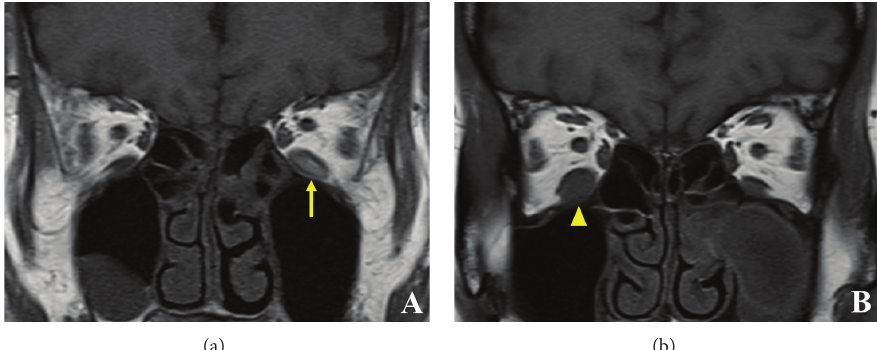
Figure 2: Adipose changes in the inferior rectus muscle (IRM) of a smoker (a) and nonsmoker (b). A large high-intensity area (arrow) in the left IRM is illustrated on a T1-weighted coronal magnetic resonance image (a). A small high-intensity area (arrowhead) in the right IRM is demonstrated on a T1-weighted coronal magnetic resonance image (b).